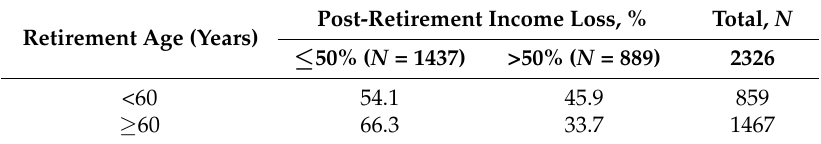
Table 2. Percentage of post-retirement income loss among retirees reporting decreased